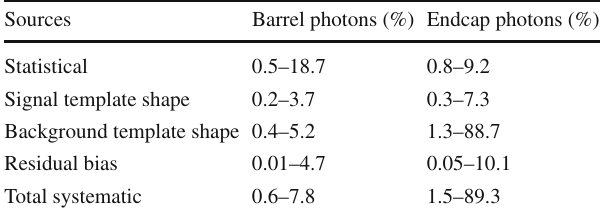
Table 1 Summary of uncertainties in the estimated purity for photons in the barrel (endcap) region